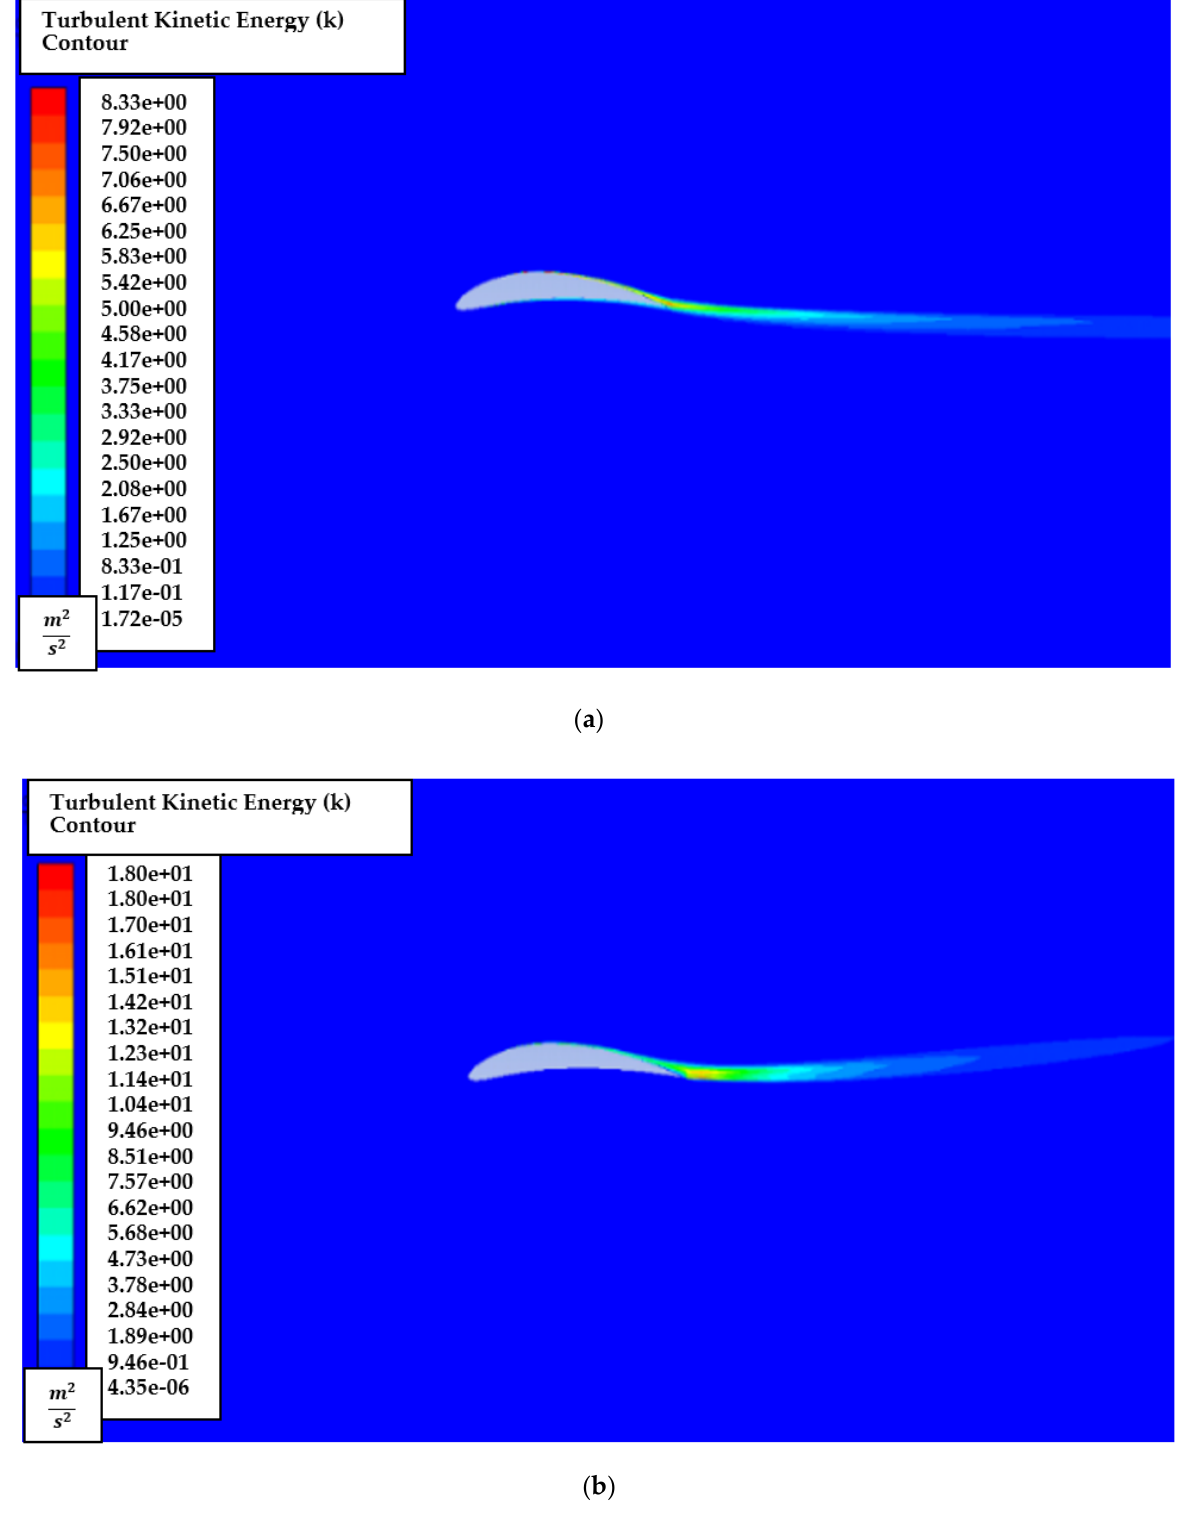
Figure 14. Turbulent kinetic energy contour of NACA8410 simulation with AoA ( a ) 1° and ( b ) 8°. For a more direct and precise comparison, the pressure distribution plots around NACA2410 and NACA8410 airfoils are presented in Figure 15. The pressure difference between the top and the bottom surface of the NACA8410 shown in purple is more sig- nificant than the pressure differences of the NACA2410 in orange. That correlates to higher 𝐶 (cid:3005) and 𝐶 (cid:3013) for NACA8410 than for NACA2410. Figure 15. Pressure distribution of the NACA8410 with varying AoA while x ticks from 0 with in- crement of 0.32; (0, 0.32, 0.64, 0.96, 1.28, 1.6, and 1.92 respectively). 4.3. From NACA2410 to NACA8410 Transition The NACA2410 on one side and the NACA8410 on the other for transitional morph- ing have been analyzed to simulate morphing wings in transition. As a result, the cross-